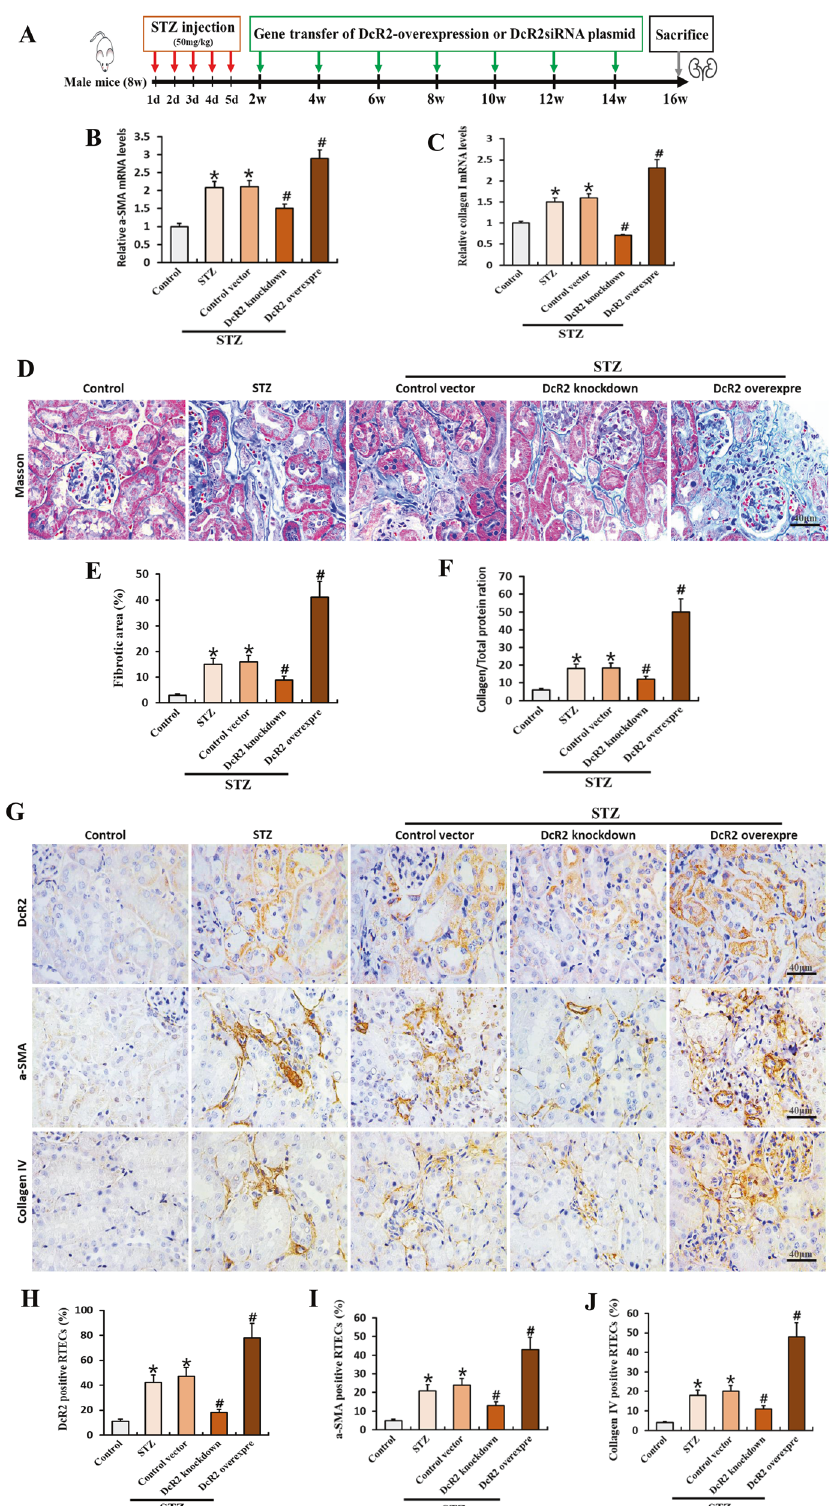
Fig. 2 Elevated DcR2 exacerbates renal fi brosis in STZ-induced DN. A Experimental design. Red arrows indicate the injection of STZ (mg/kg), while green arrows indicate the transfer of pLenti-C-mGFP DcR2 overexpression or pGFP-C-shLenti DcR2-siRNA plasmids. B , C qRT-PCR results for α -SMA and collagen I mRNA levels in each group ( n = 6). D , E Masson trichrome staining showing renal fi brosis (blue) and the percentage of fi brosis in different groups after quantitative analysis. Scale bar, 40 μ m. F Total collagen in each group ( n = 6). G Immunohistochemical staining for DcR2, α -SMA, and collagen IV. Scale bar, 40 μ m. H – J . The percentage of positive RTECs was quanti fi ed ( n = 6 – 7). Data are expressed as the mean ± SD for each group. * P < 0.05 versus control; # P < 0.05 versus STZ.